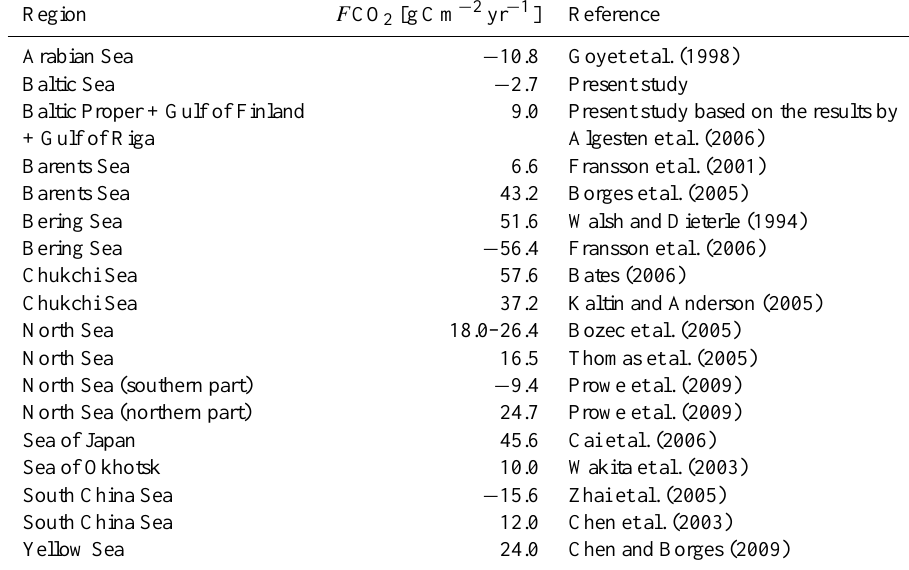
Table 4. Comparison of the F CO 2 results calculated for the Baltic Sea with the literature data for other shelf seas. Positive values of the F CO 2 indicate CO 2 sequestration in seawater, whereas negative ones indicate emission of CO 2 to the